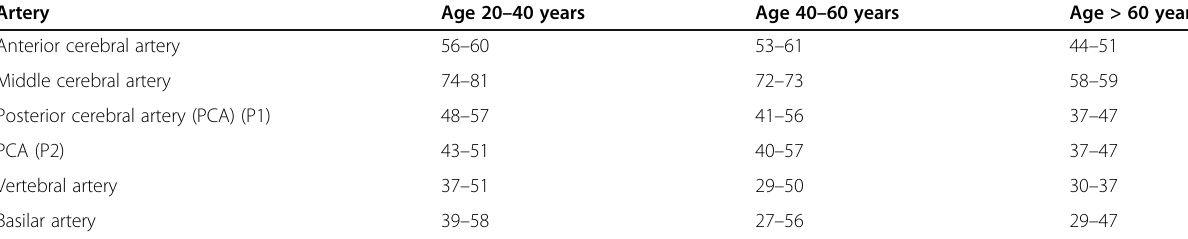
Table 1 Mean cerebral blood flow velocities (cm/s) based on age groups [5] Artery